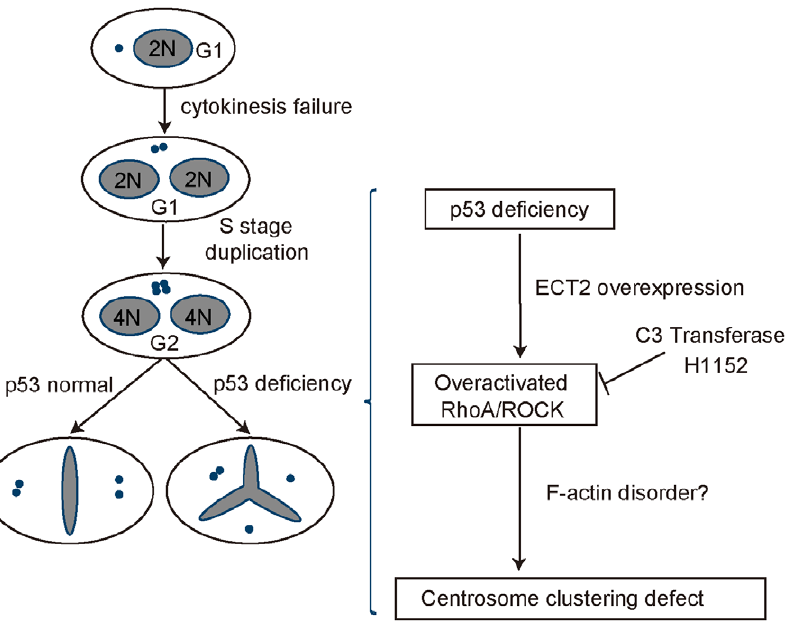
Figure 6. p53 deficiency contributes to multipolar mitosis in tetraploid cells. The model shows that p53 abnormality is a major cause for multipolar mitosis in tetraploid cells. Specifically, we propose that a number of distinct primary cell cycle errors such as cytokinesis failure leads to tetraploid cells with 4N DNA and two centrosomes. These cells undergo DNA replication and centrosome duplication before entering mitosis, giving rise to octoploidy with four centrosomes. In p53 proficient cells, most of them will undergo bipolar mitosis, most likely through clustering extra centrosomes, though a mechanism inactivating extra centrosomes may also occur. In the absence of a functional p53, however, ECT2 is overexpressed, and then RhoA/ROCK is overactivated, which impairs the ability of clustering extra centrosomes most likely through disrupting the arrangement of actin cytoskeleton and leads to multipolar mitosis, giving rise to chromosomal instability and aneuploidy. doi:10.1371/journal.pone.0027304.g006 PLoS ONE |